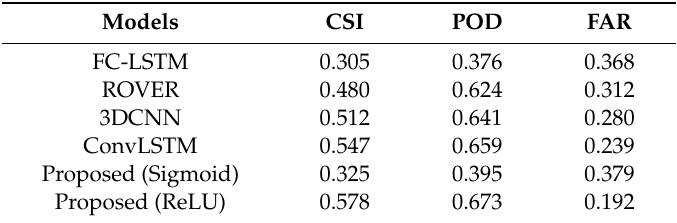
Table 3. Performance comparison of di ff erent models of the 10dBZ threshold.